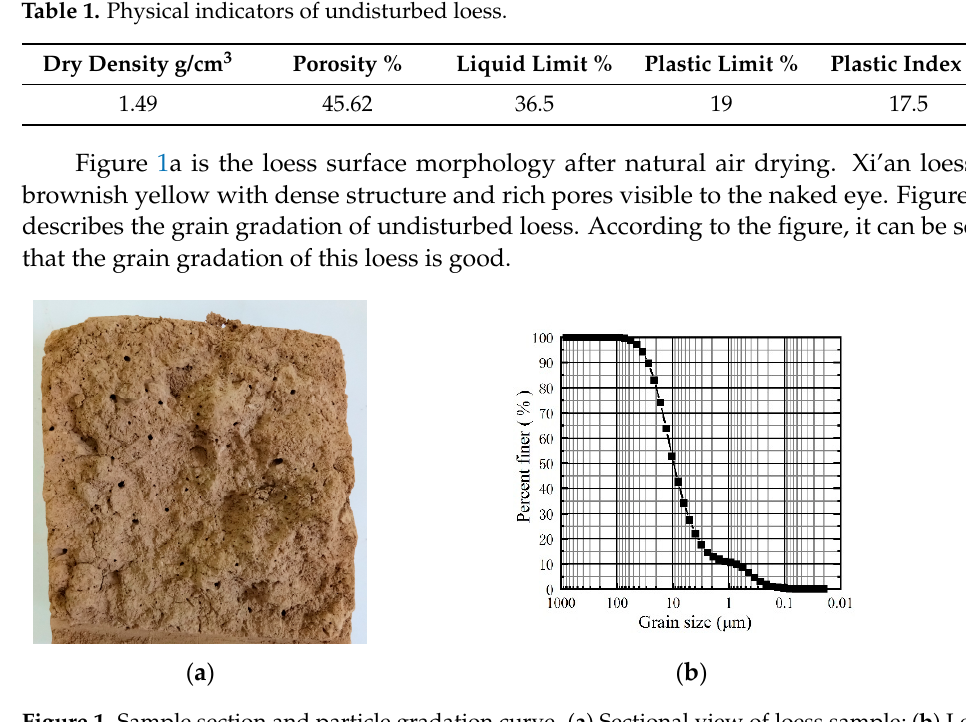
Figure 1. Sample section and particle gradation curve. ( a ) Sectional view of loess sample; ( b ) Loess particle gradation curve.